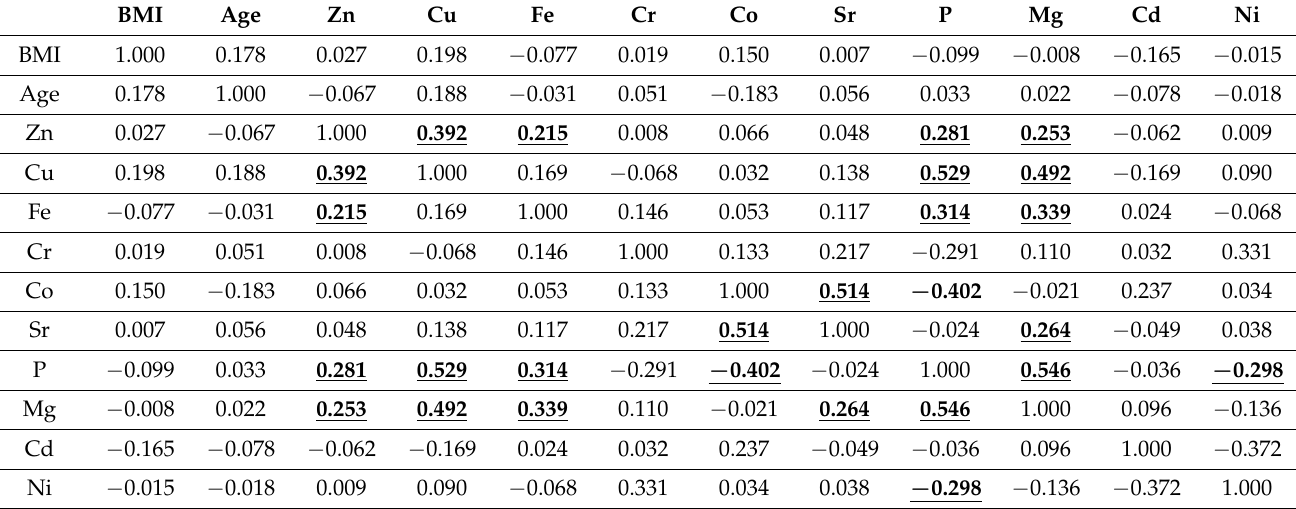
Table 4. Spearman